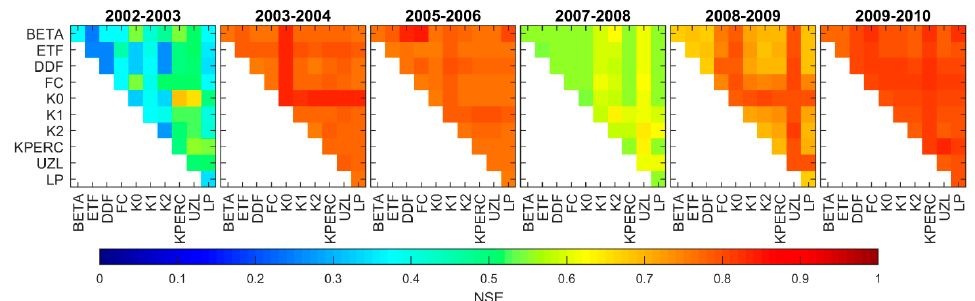
Figure 7. Heatmaps representing the maximum NSE obtained when varying two model parameters at a time while the rest are set to their optimized values.